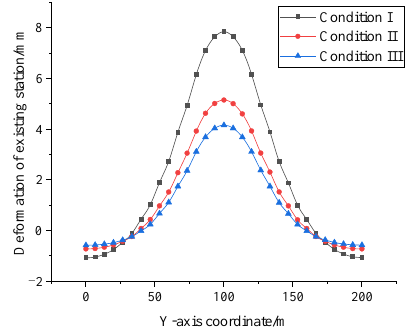
Figure 7. Deformation curve of existing station.